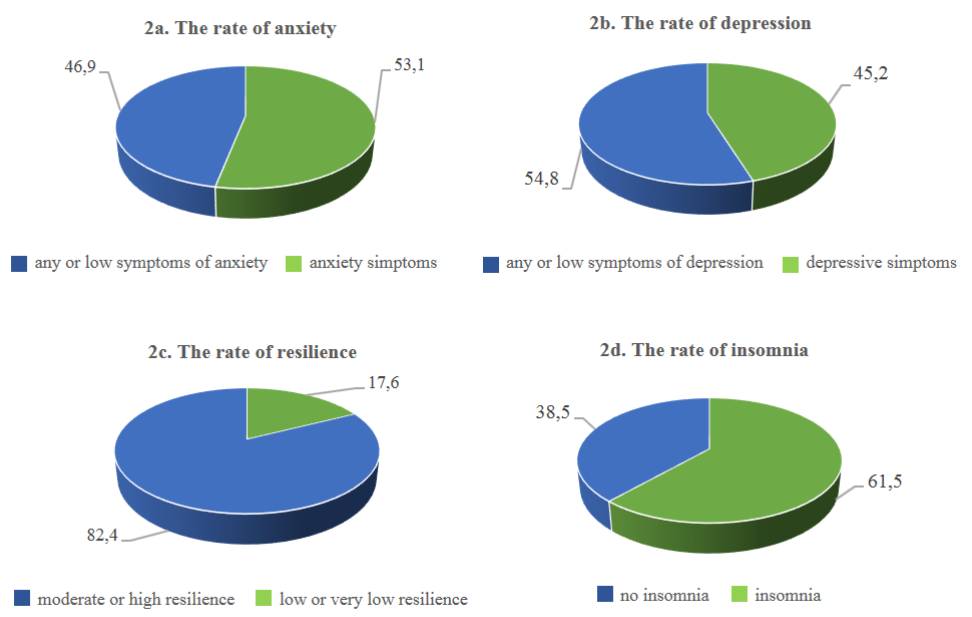
Figure 2. The rate of anxiety, depression, resilience and insomnia among intensivists (variables are expressed as percentages).